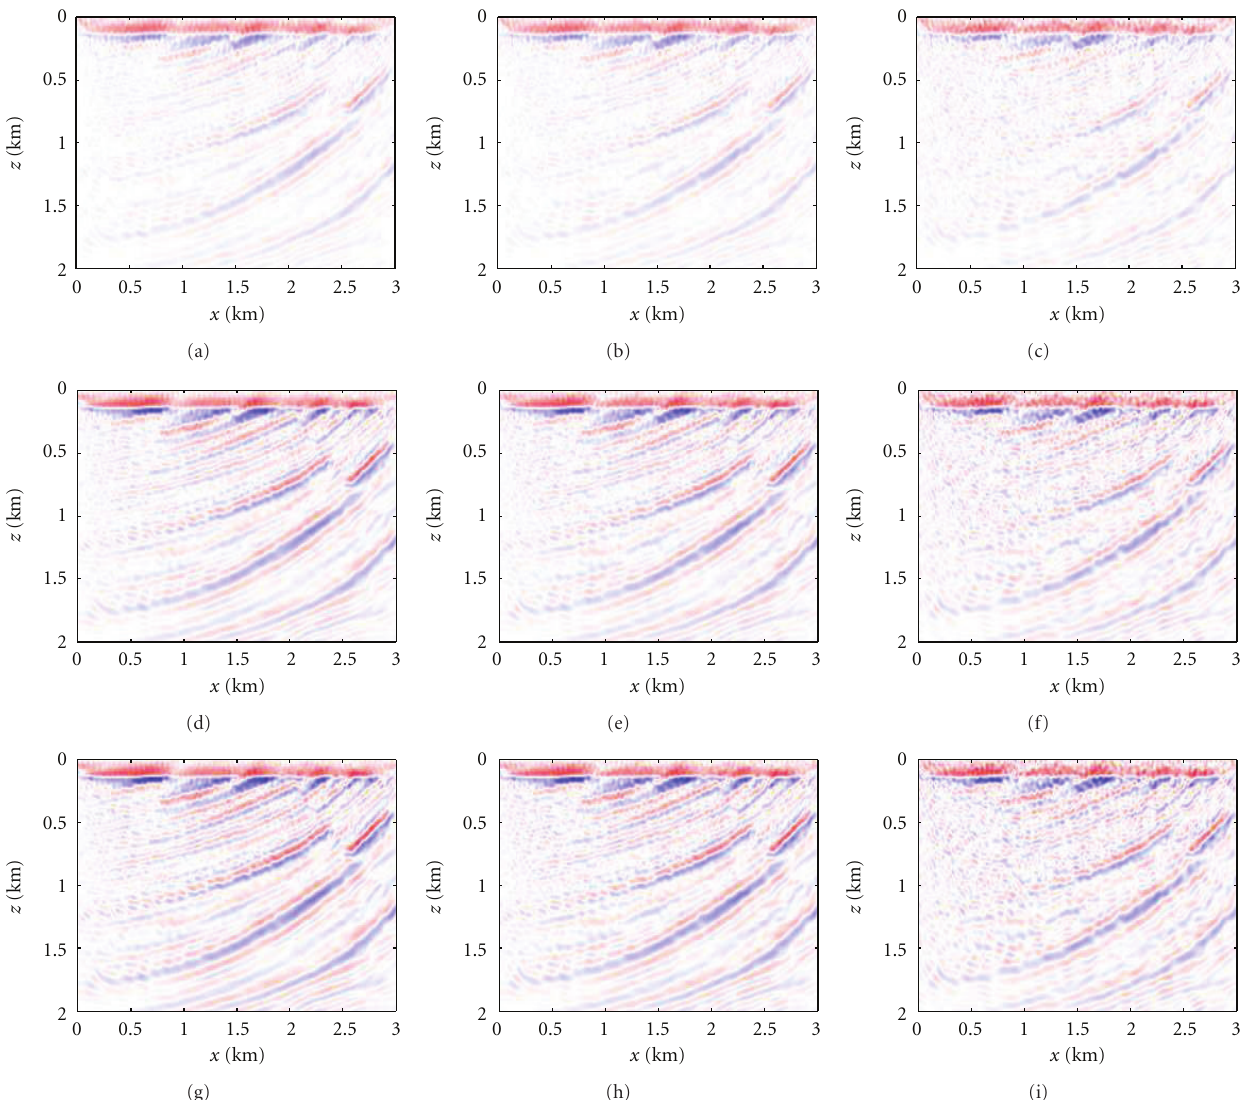
Figure 13: Inversion result for the SA approach with full averaging ( n = 500) for various batch sizes and noise levels. The rows represent di ff erent batch sizes K = 1, 5, 10, while the columns represent di ff erent noise levels: no noise, SNR = 20 dB, and SNR = 10dB. Averaging over the full past dramatically deteriorates the